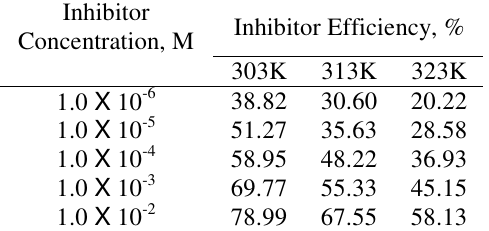
Table 5. The inhibition efficiency (%) for mild steel corrosion in 2 M HCl solution by 2- benzoylpyridine at different temperatures.